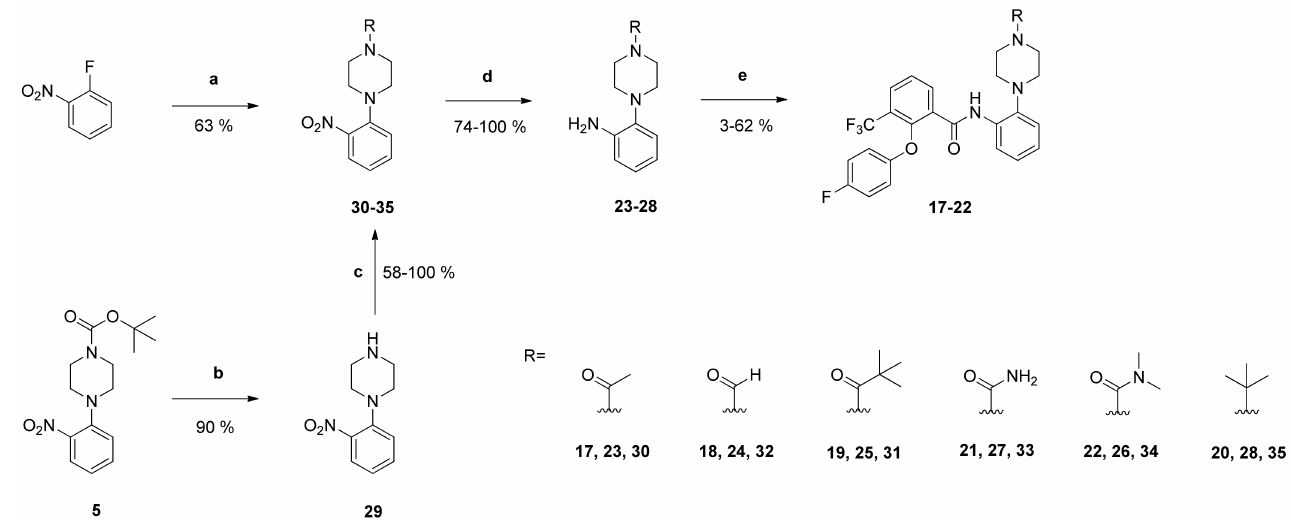
Figure 4. Preparation of compounds 17 – 22 . Reagents and conditions: ( a ) tert -butyl-piperazine, K 2 CO 3 , DMSO, 80 ◦ C, 72 h; ( b ) trifluoroacetic acid, CH 2 Cl 2 , rt, 24 h; ( c ) triethylamine, acetyl chloride, acetonitrile, rt, 24 h (compound 30 ) or (1) triethylamine, CH 2 Cl 2 , 0 ◦ C, 5 min; (2) pivaloyl chloride, rt, 24 h (compound 31 ) or (1) Na, Et OH, rt; (2) Et OH, 50 ◦ C, 15 min; (3) CHCl 3 , 50 ◦ C, 30 min (compound 32 ) or 1 N HCl, 2 N KOH, potassium cyanate, rt, 2 h (compound 33 ) or (1) triethylamine, 1,1 (cid:48) -carbonyldiimidazole, rt, 30 min; (2) dimethylamine hydrochloride 80 ◦ C, 6 h (compound 34 ); ( d ) 15% (m/m) palladium on activated carbon, H 2 , Me OH, rt, 24 h; ( e ) (1) carboxylic acid 2 , CH 2 Cl 2 , 0 ◦ C, 5 min; (2) 2-chloro- N -methylpyridinium iodide, DIPEA, rt, 24